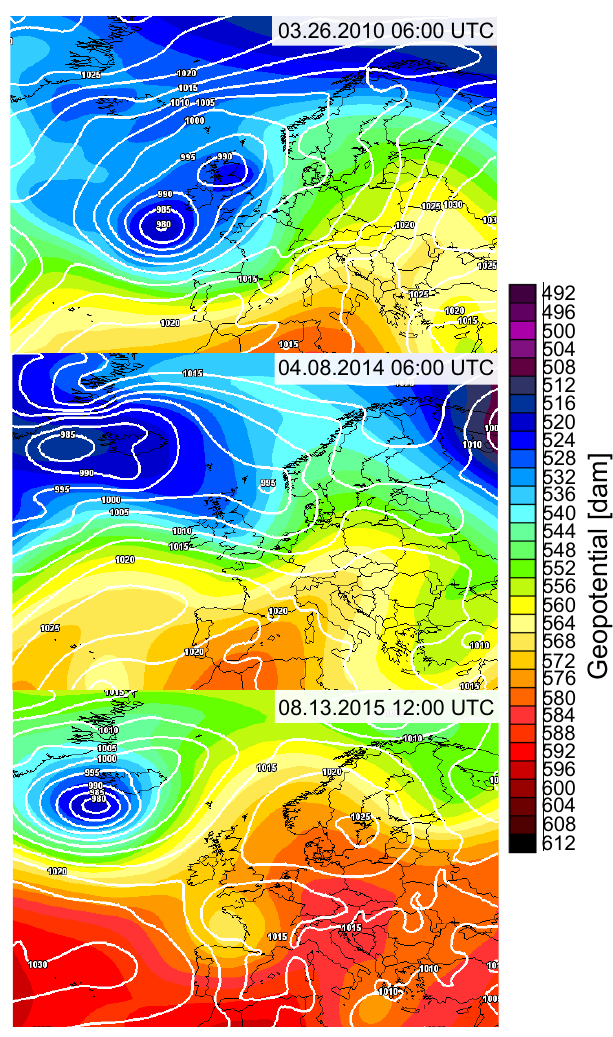
Figure 1. 500hPa geopotential and pressure at mean sea level for the three considered